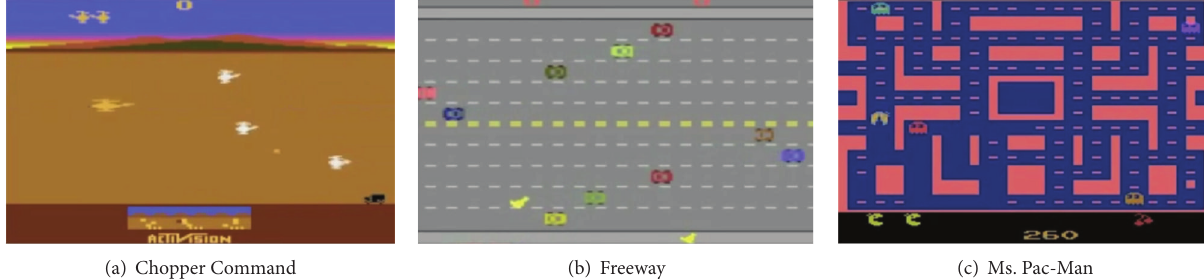
Figure 5: Examples of games in the Arcade Learning